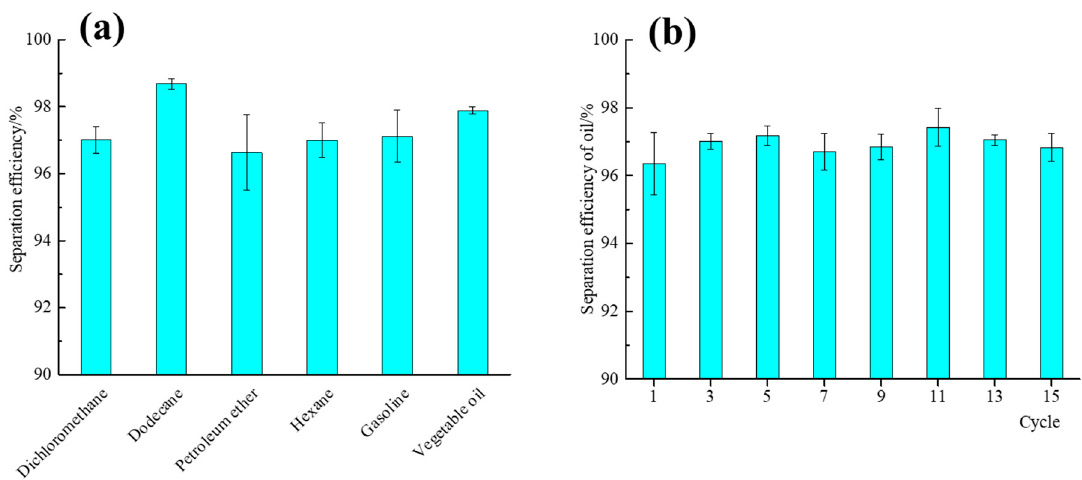
Figure 9. ( a ) Separation efficiency of the treated PP filter cloth for various oil–water mixtures. ( b ) Separation efficiency of the treated PP filter cloth for dichloromethane–water mixture after 15 cycles.